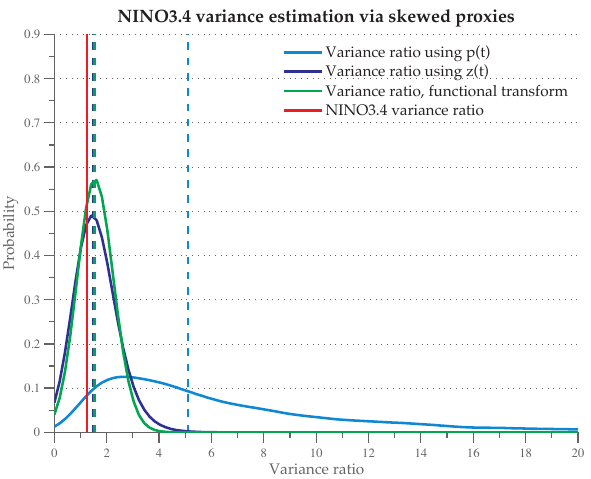
Figure 3. Distributions of estimated NINO3.4 variance ratios within the periods 1900–1949 and 1950–1999, using positive proxy excursions. Light blue: distribution of ratios from 10000 samples of p ( t ) derived according to Eq. (1) with noise variance set to 0.25 (compare with the dark grey curve in Fig. 1); dark blue: distribution of ratios estimated from z ( t ), the empirical transform of each sample of p ( t ) (compare with the dark grey curve in Fig. 2); green: distribu- tion of ratios estimated from the functional transform (( p/α ) β ). In each case, the median is indicated with a dashed vertical line of the same colour, while the ratio estimated from the original NINO3.4 series is indicated in